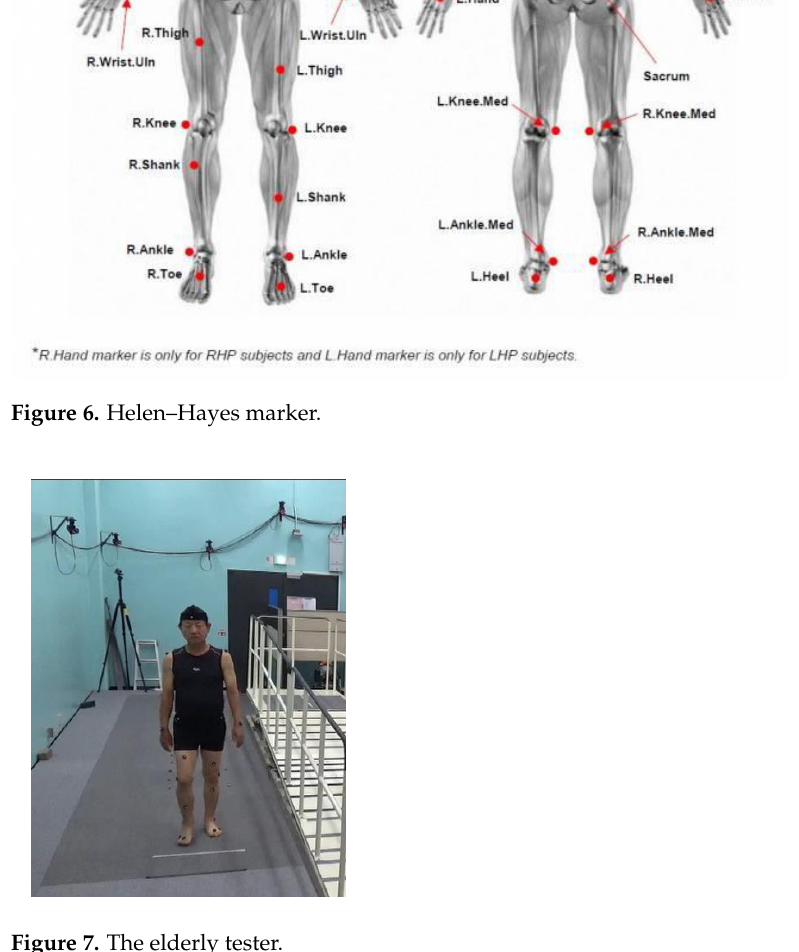
Figure 8. Motion analysis results (example).